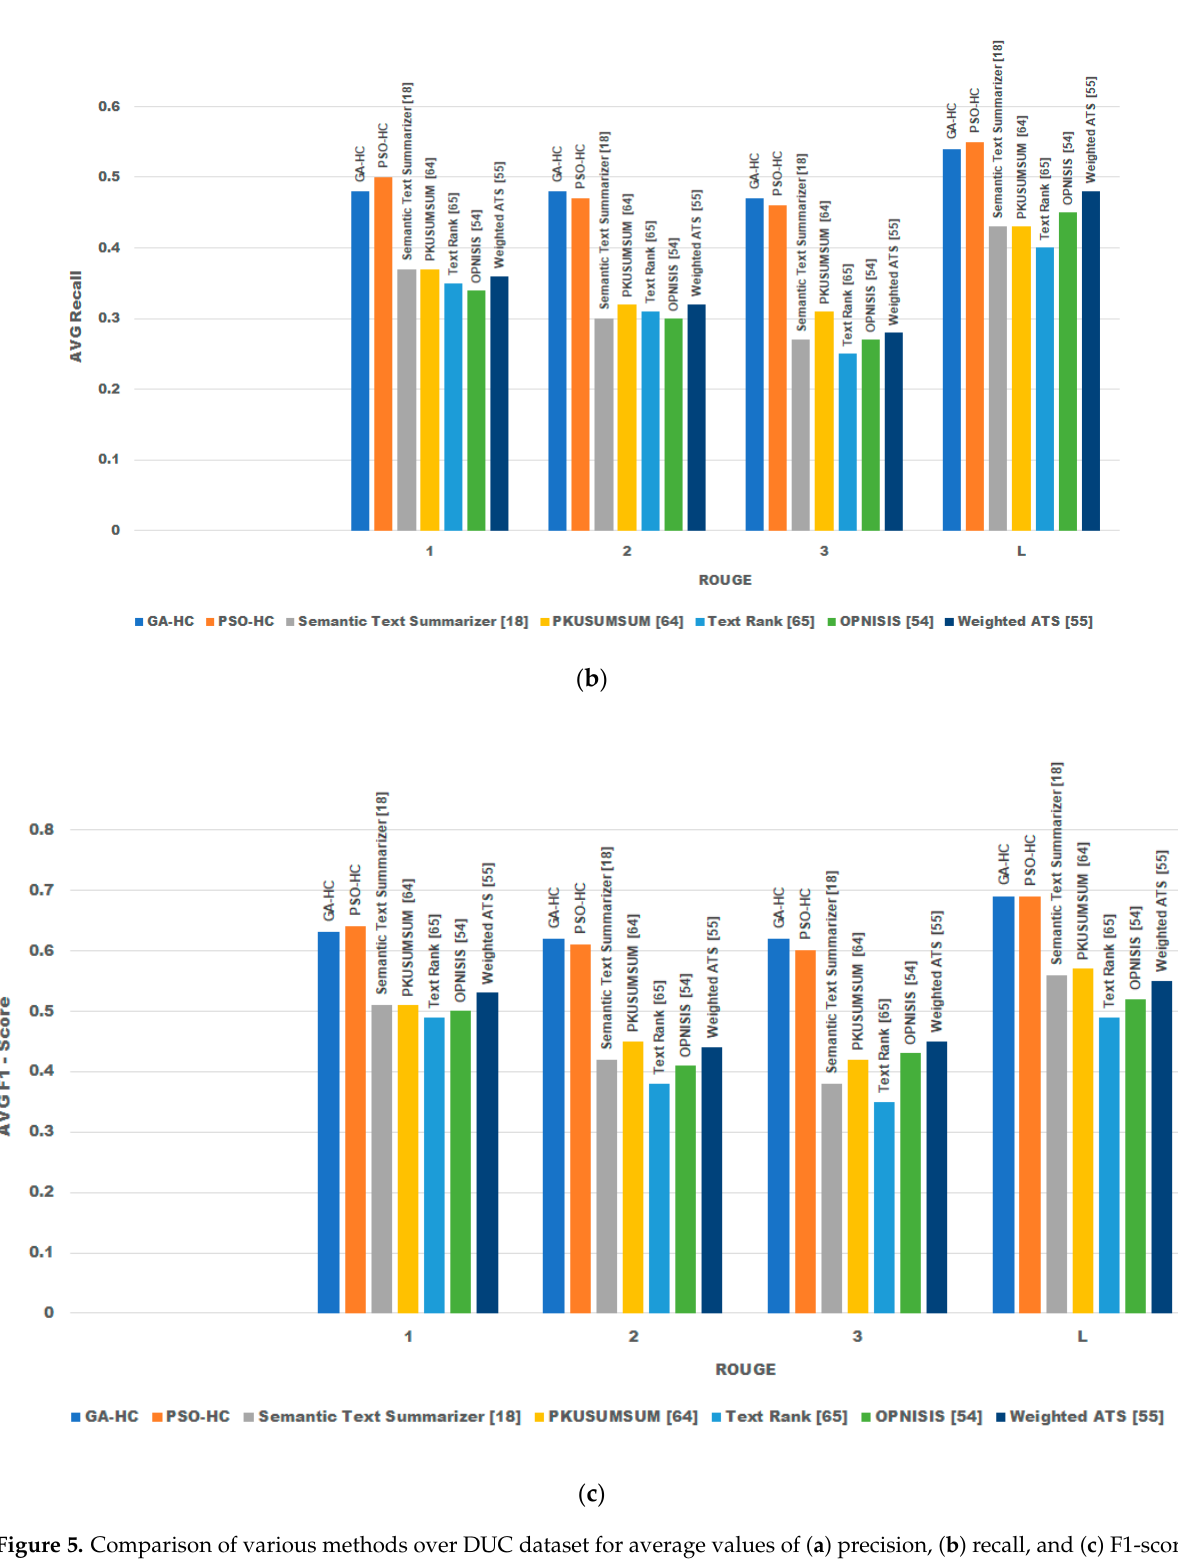
Figure 5. Comparison of various methods over DUC dataset for average values of ( a ) precision, ( b ) recall, and ( c ) F1-score.